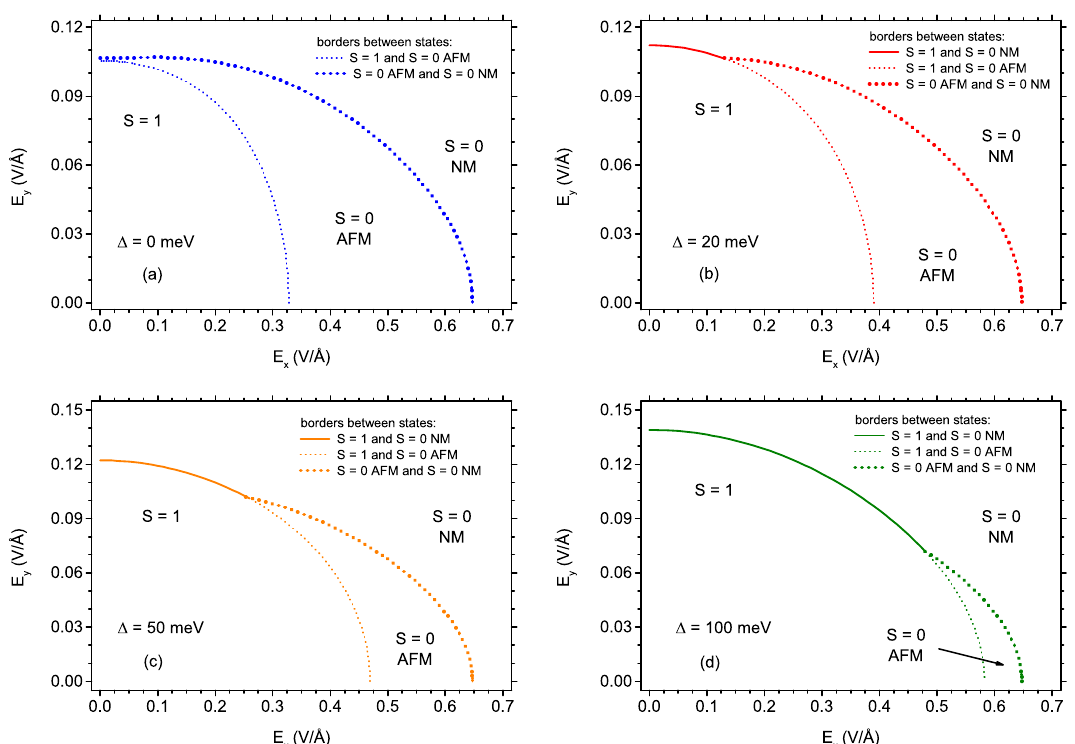
Figure 5. The phase diagram showing the borders between the state with S = 1 and the AFM and NM states with S = 0 as a function of the electric field along the x -direction and along the y -direction, for four values of exchange energy: 0 meV ( a ); 20 meV ( b ); 50 meV ( c ); and 100 meV ( d ). The solid lines delimit S = 1 and S = 0 NM state; the dashed lines delimit S = 1 and S = 0 AFM state; the dotted lines delimit S = 0 AFM and NM